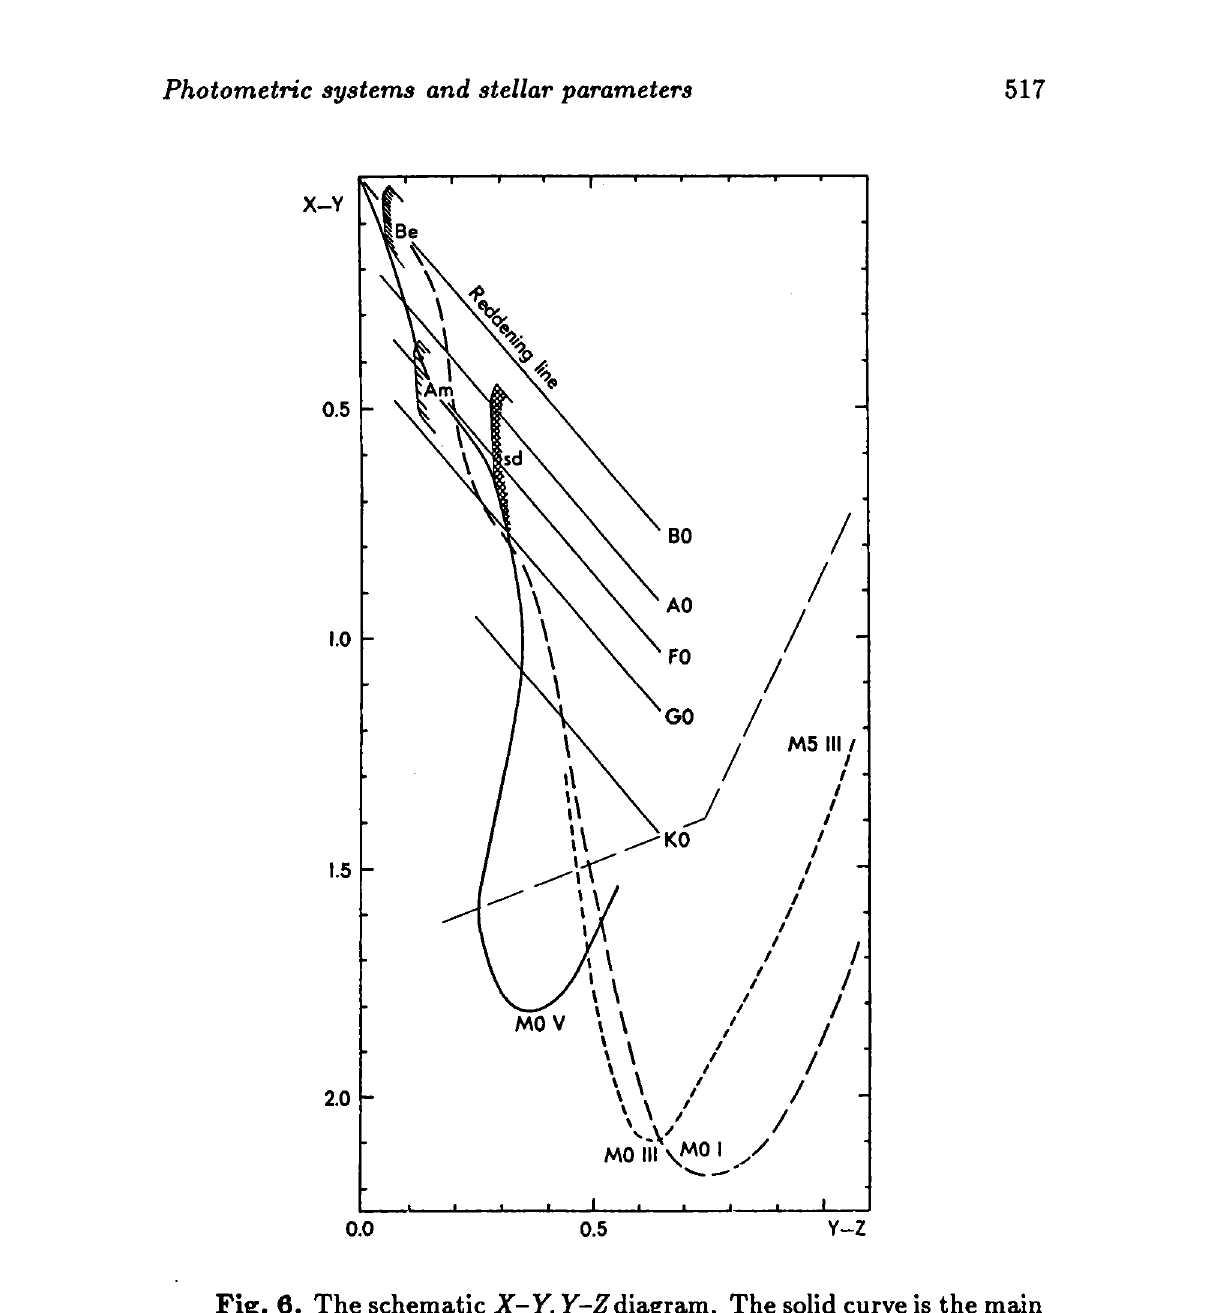
Fig. 6. The schematic X-Y, Y-Z diagram. The solid curve is the main sequence, the short-dashed line is the giant sequence, the long-dashed line is the supergiant sequence, the parallel straight lines are reddening lines of BOV, AOV, FOV, GOV and KOV stars, the two intersecting broken lines separate the area in which M-type stars of various luminosities are met. The blue limits of Be and Am stars and subdwarfs are